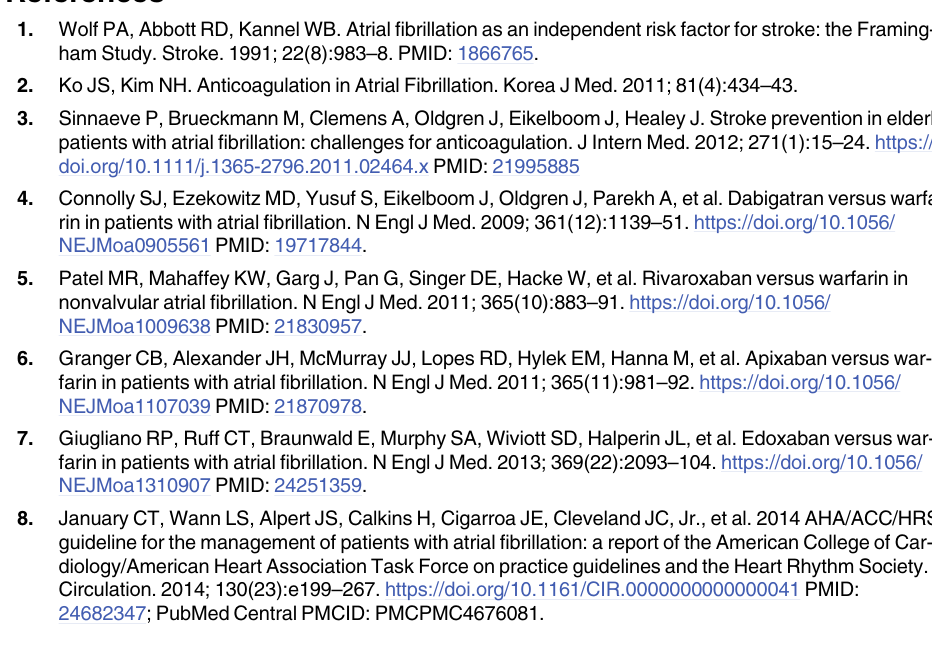
S5 Table. Indications and recommended doses of direct oral anticoagulants in 2014. S6 Table. Diagnosis and procedure codes used to find patients with deep vein thrombosis, pulmonary embolism, and hip or knee replacement. S7 Table. Medication codes of contraindicated drugs of direct oral